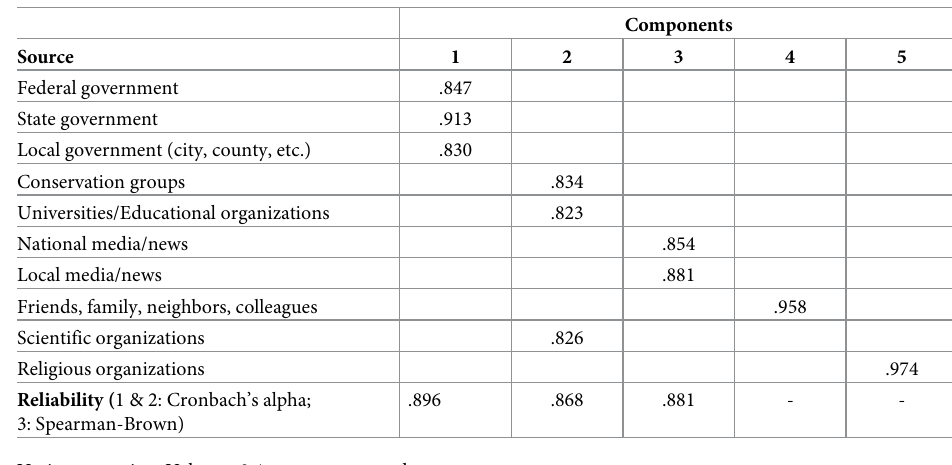
Table 7. Principle component analysis for trust in